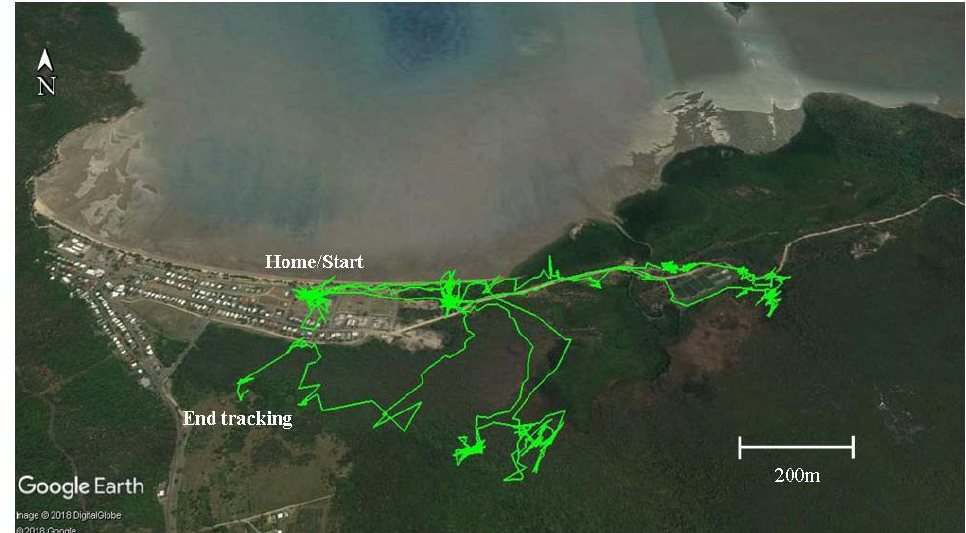
Figure 2. Track map from i-gotU GT-600 (Mobile Action Technology, Taipei, Taiwan) data logger for female domestic dog CD01 over 96 h in Yarrabah showing forays away from urban boundaries as viewed on Google Earth engine.